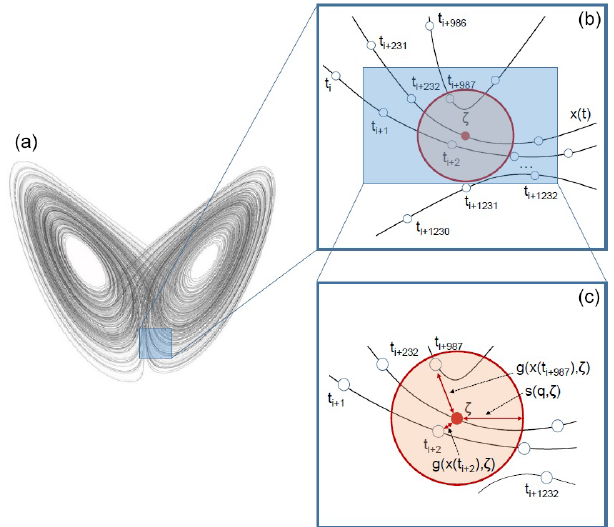
Figure 1. Schematic of the computation of the dynamical systems metrics for a state ζ (for ease of notation we drop the x subscript used in the text) on the Lorenz ’63 attractor. All trajectory segments shown on the right-hand side panels are part of a single, long tra- jectory x ( t ). The white circles along the trajectory represent dis- crete, instantaneous measurements of the continuous evolution of the trajectory, with the index i referring to some reference time rel- ative to which the measurements are taken.. The state of interest ζ is shown in red. Panel (c) illustrates the hyper-sphere determined by the high threshold s ( q, ζ ), which defines recurrences, and the logarithmic distances between measurements defined by g ( x ( t ) , ζ ). Here, g takes large values for small separations. Thus, for all points within the hyper-sphere, we find that g ( x ( t ) , ζ ) > s ( q, ζ ). In the schematic, only two measurements satisfy this condition (adapted from Faranda et al.,